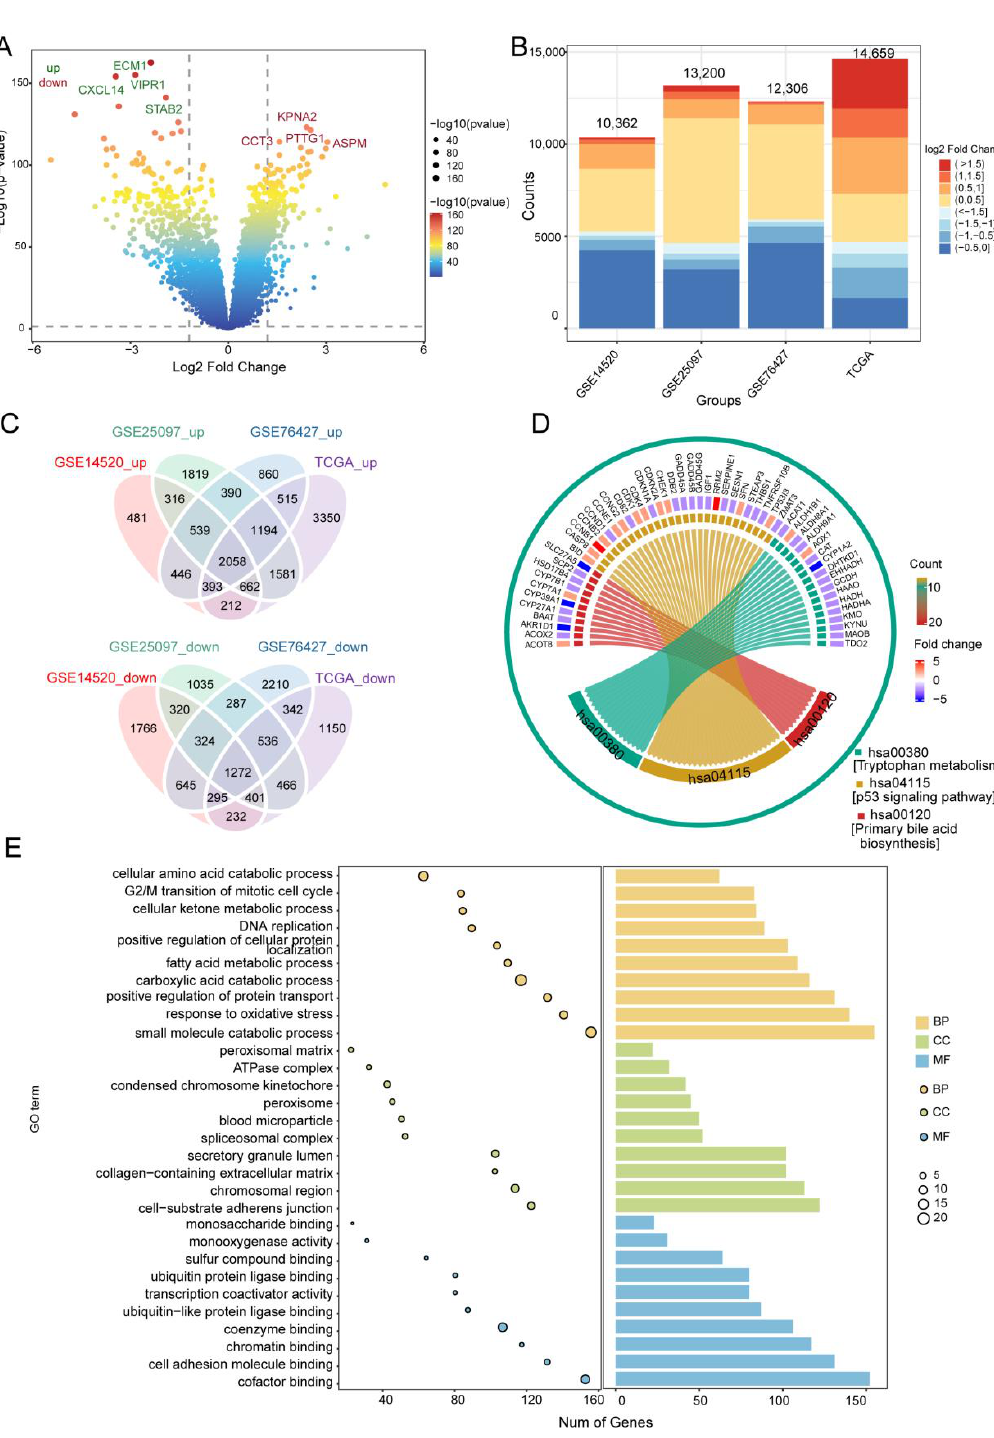
Figure 2. Differentially expressed genes (DEGs) in HCC and their enrichment in biological processes and KEGG pathways. ( A ) DEGs in the GSE14520 dataset. Red indicates upregulated genes and blue, downregulated genes. ( B ) Bar diagram of DEGs in the GSE14520, GSE25097, GSE76427, and TCGA datasets. ( C ) Up- and downregulated DEGs overlapping across the datasets, as visualized in a Venn diagram. ( D ) Overlapping DEGs enriched in various KEGG pathways. ( E ) GO terms of overlapping DEGs, including BP, CC, and MF. The x-axis represents the number of DEGs involved in GO terms, and the y-axis the significantly enriched GO terms. BP, biological process; CC, cellular component; MF, molecular function; GO, gene ontology; HCC, hepatocellular carcinoma; KEGG, Kyoto Encyclopedia of Genes and Genomes; TCGA, The Cancer Genome